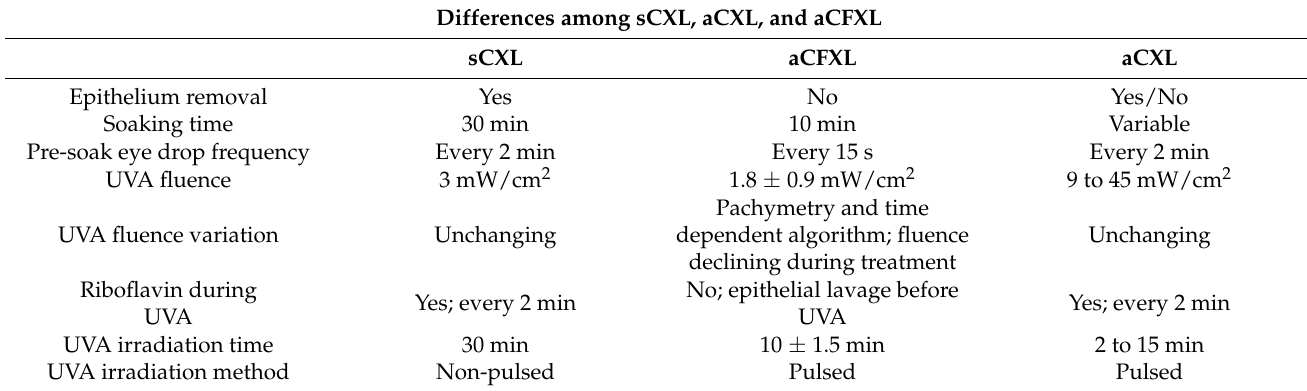
Table 1. Different cross-linking